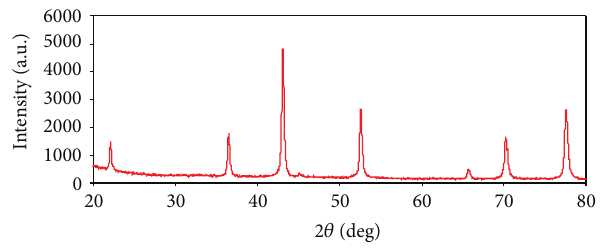
Figure 1: XRD pattern of MgAl 2 O 4 phosphor.